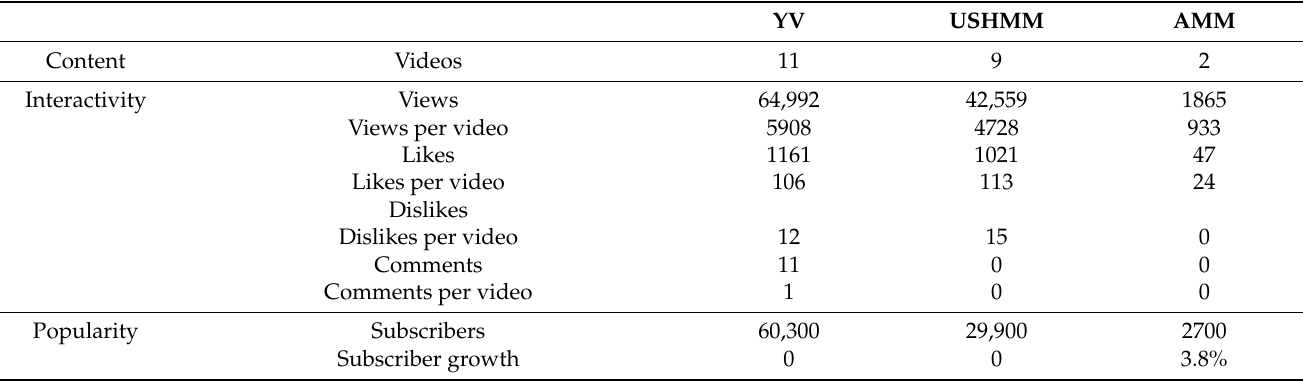
Table 6. Content, interactivity, and popularity of museums’ YouTube